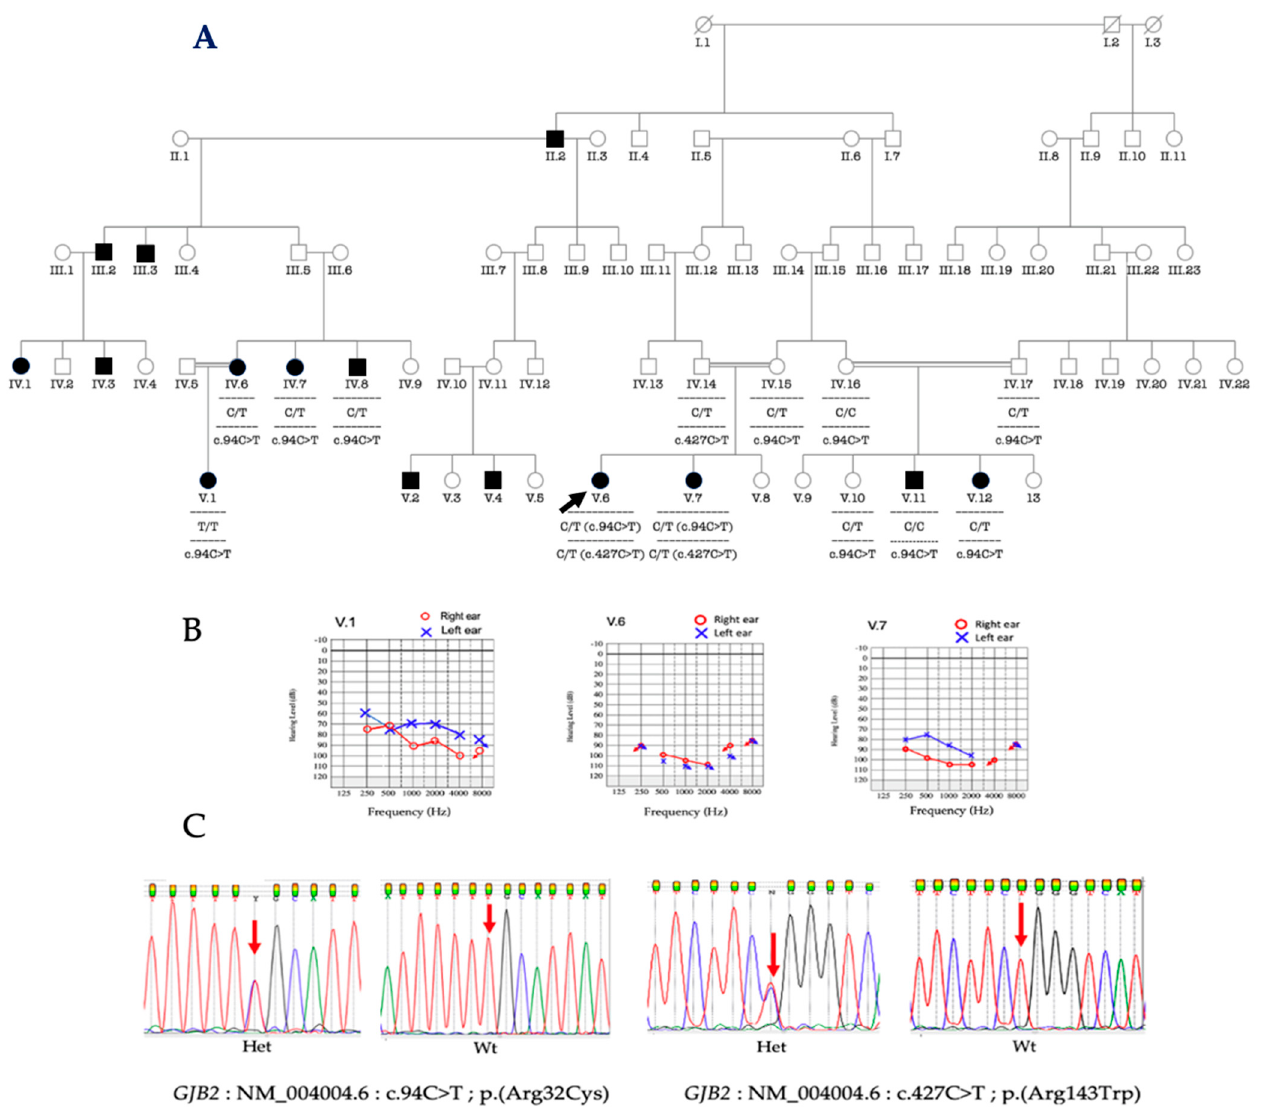
Figure 2. Pedigree of a multiplex family segregating HI with observed genotypes. V.6 is the proband ( A ); audiological phenotypes of the proband V.6, and her sister V.7, and the cousin from the father’s side, V.1 ( B ); electropherograms of pathogenic variants in GJB2 ( C ); Het, heterozygous; Wt, wild type. Black arrow indicates the proband. The red arrows indicate the nucleotides affected by the variant.